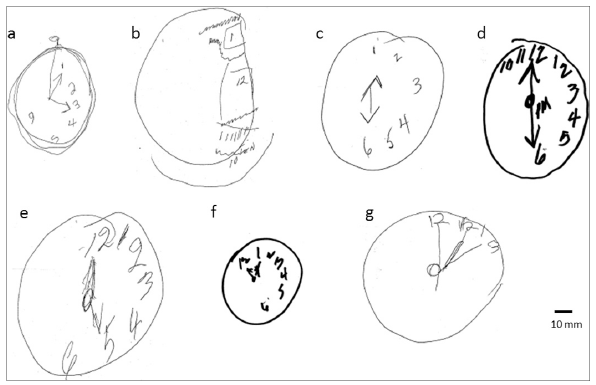
Figure 1. When patients with representational neglect are asked to draw an analogue clock from memory, the numbers are placed in their non-neglected side of the clock ( a – g ). Reprinted with permission from [21]. Copyright 2022 Journal of